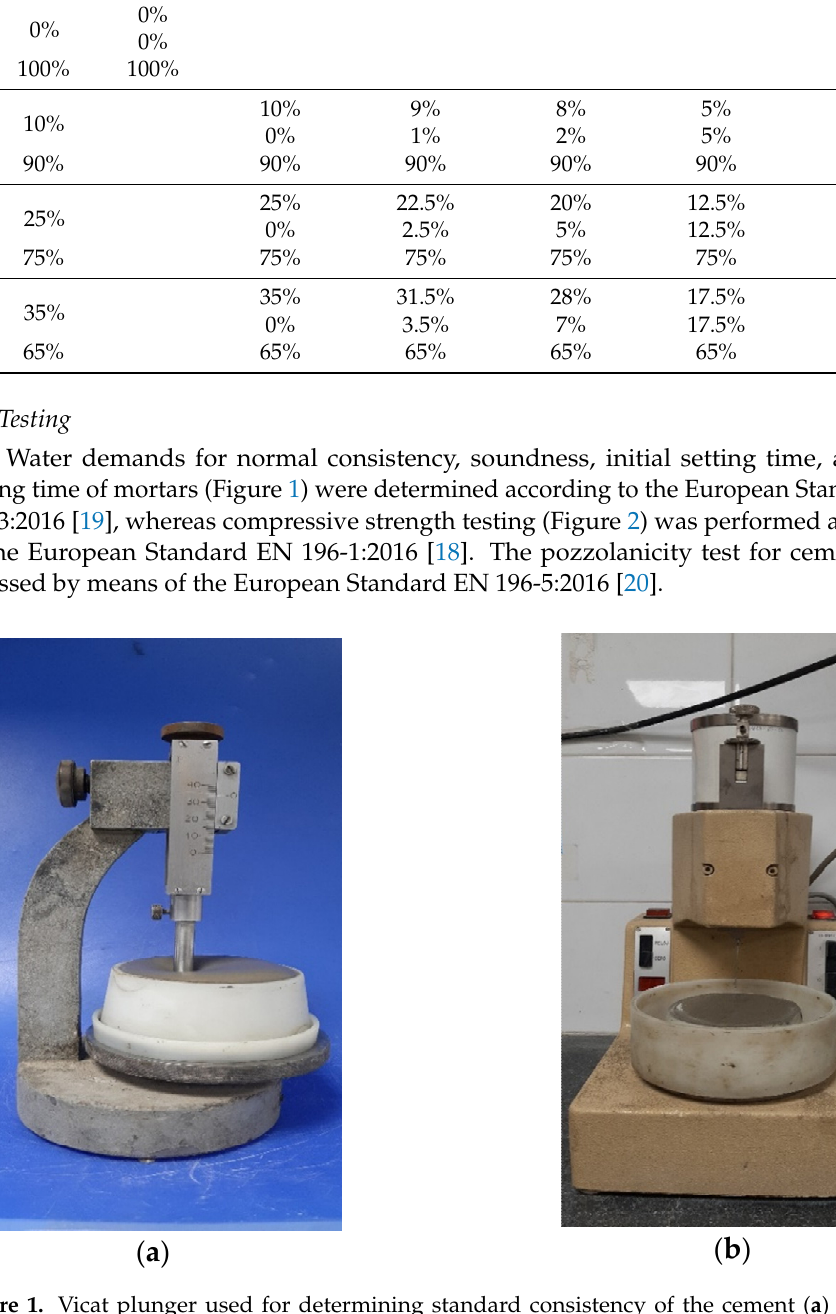
Figure 1. Vicat plunger used for determining standard consistency of the cement ( a ) and Vicat apparatus used for determining initial and final setting time of cement ( b ).